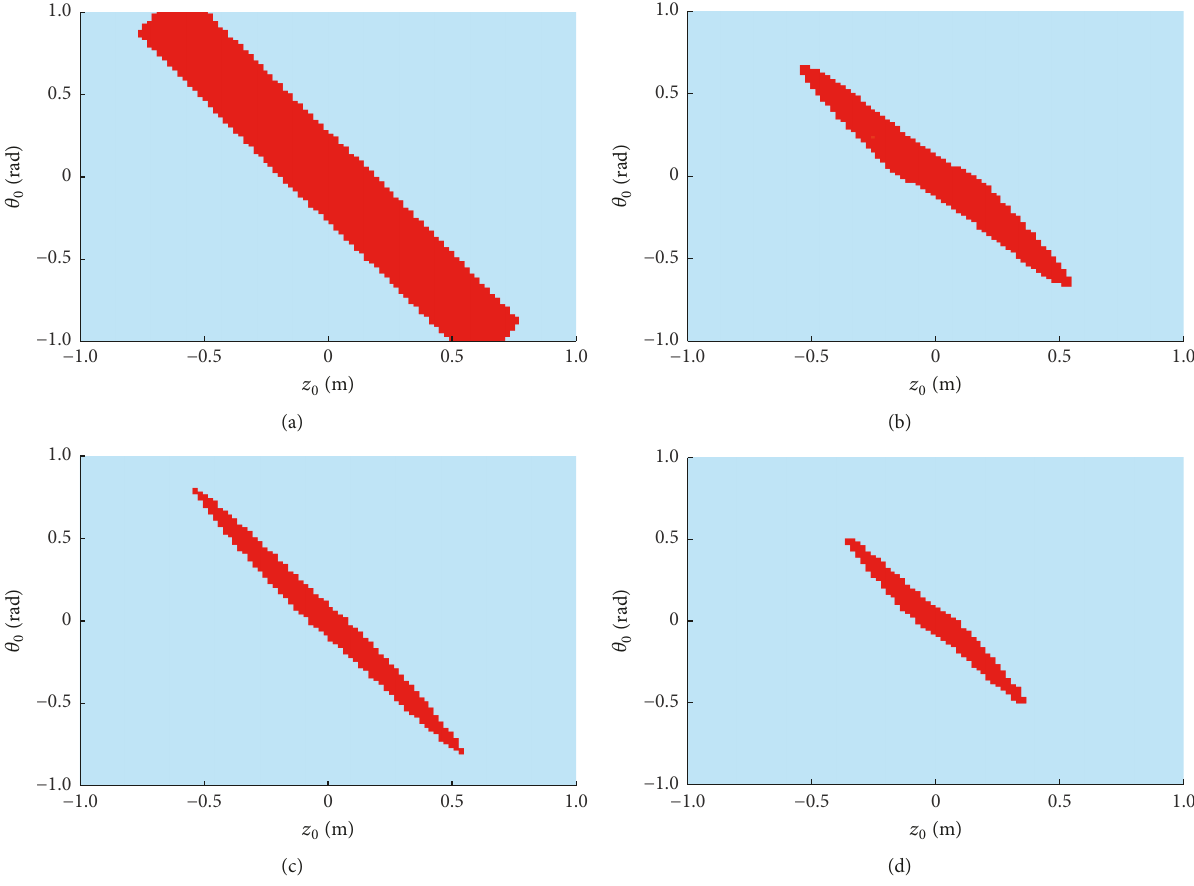
Figure 9: Basins of attraction: (a) 𝜎 = 0.02434 , 𝑘 = −87.83 ; (b) 𝜎 = 0.03040 , 𝑘 = −91.93 ; (c) 𝜎 = 0.02805 , 𝑘 = −90.9 ; (d) 𝜎 = 0.03428 , 𝑘 = −89.88